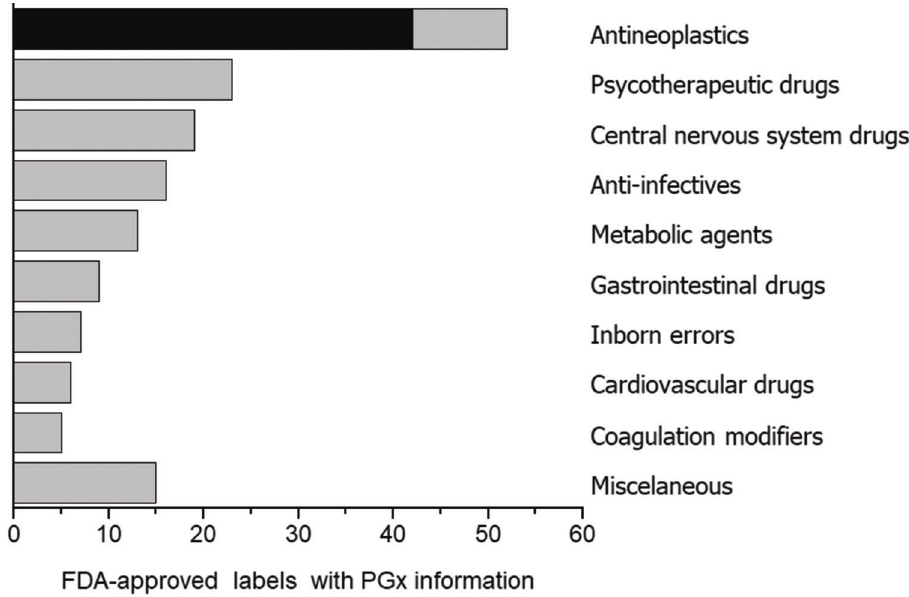
Figure 2 - Number of FDA-approved labels with PGx information for the therapeutic classes listed on the right. Source: Table of pharmacogenetic biomarkers in drug labels, https://www.fda.gov/Drugs/ScienceResearch/ucm572698.htm, accessed Jan 5,